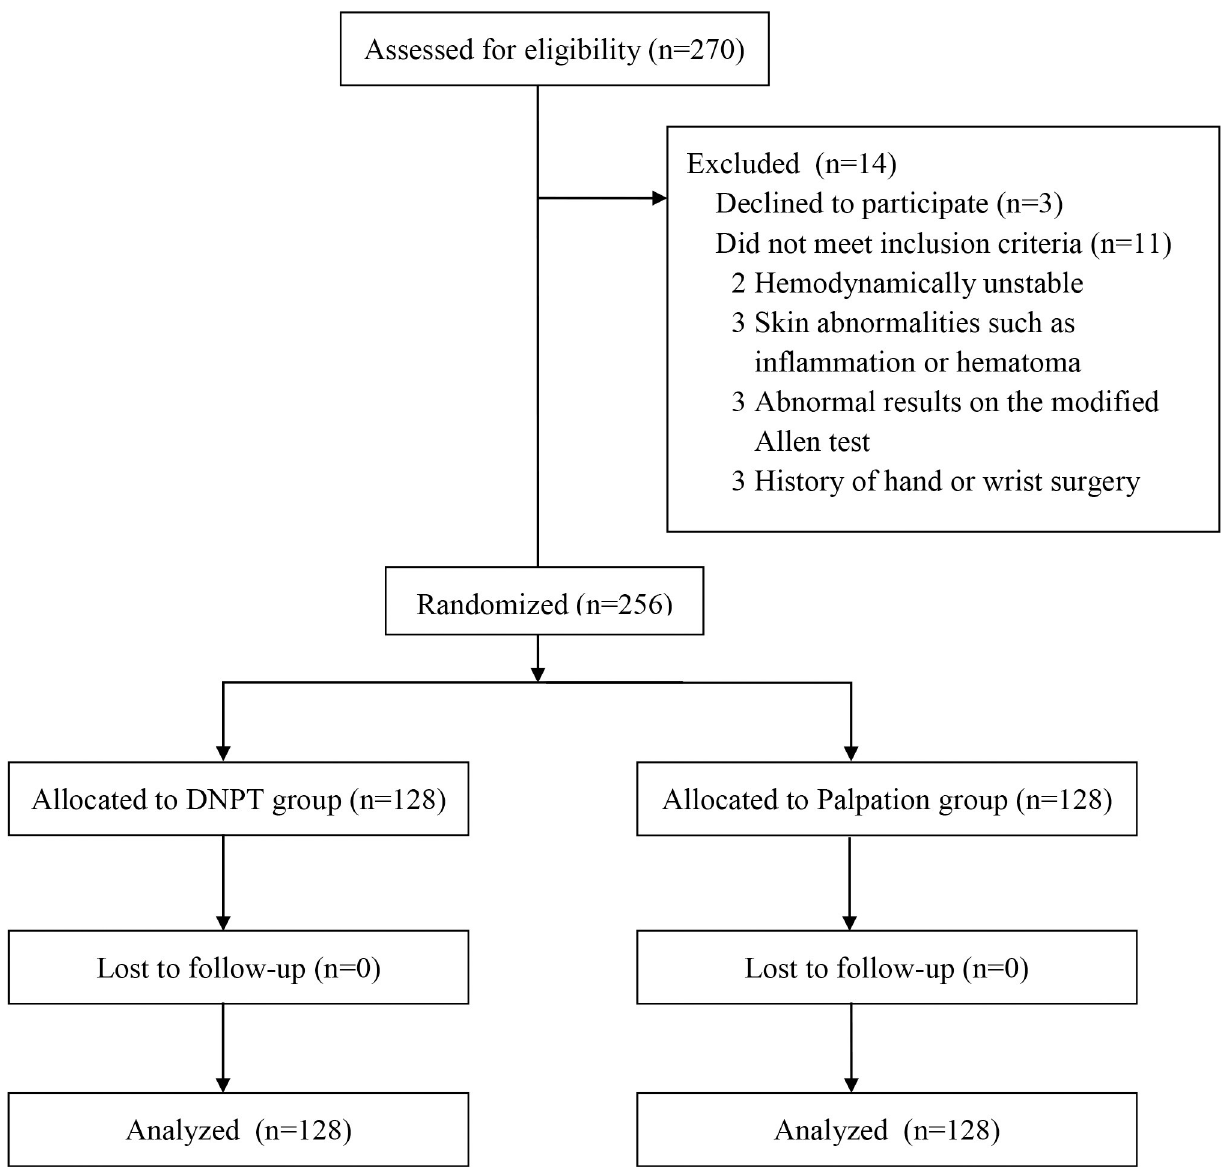
Fig 1. Flow diagram of patient recruitment and exclusion criteria for the study. DNTP, dynamic needle tip positioning technique.